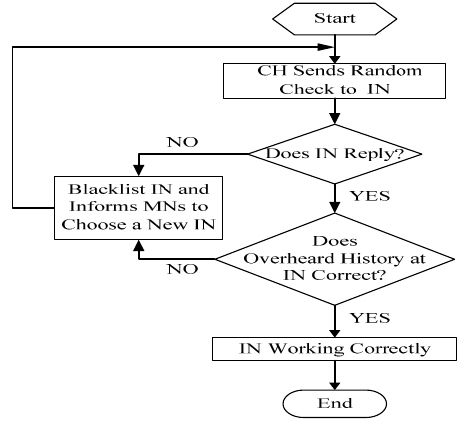
Figure 4. CH’s random check for IN.